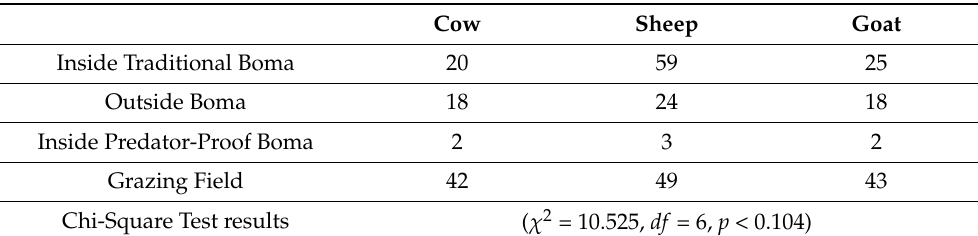
Table 2. Distribution of livestock depredation incidences in relation to the location of attack and livestock species predated on.